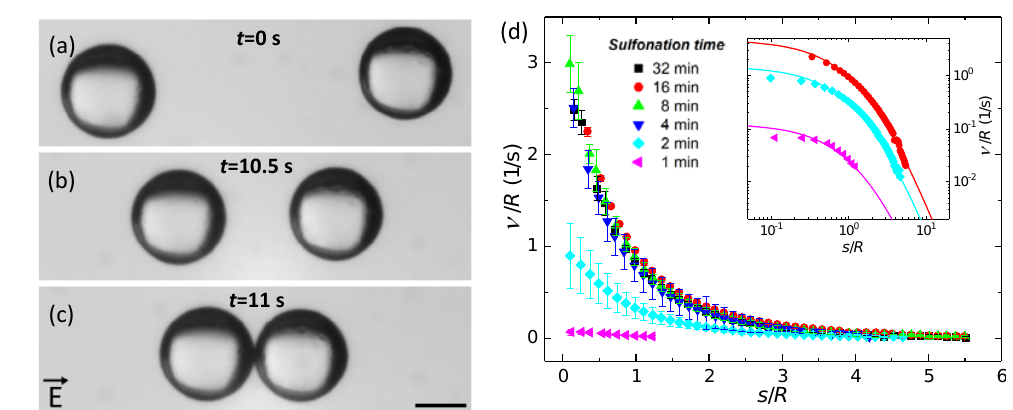
Figure 3. Dipolar force between sulfonated particles suspended in 100 mPa · s silicone oil. ( a – c ) When subjected to an AC electric field of 75 V/mm (100 Hz), the attractive dipolar force aligns and brings 140- µ m polystyrene particles (sulfonated for 16 min) together. The scale bar is 100 µ m, and the electric field is in the horizontal direction; ( d ) Average particle speed plotted versus average particle separation for PS particles sulfonated for 1–32 min. In the inset, the data points of particles sulfonated for 1, 2, and 16 min are fitted with a dipolar model (for details, see below). The data points for the other particles (sulfonated for 4, 8, and 32 min) overlap with the data points for PS16 (red circles) and are omitted for visual clarity.